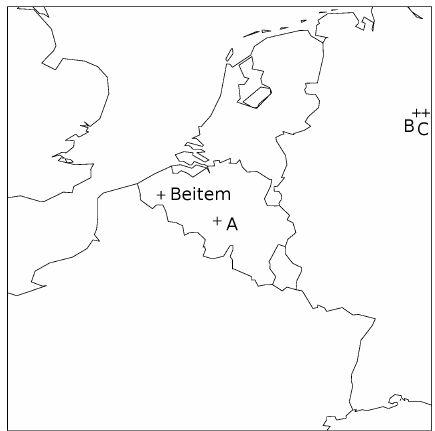
Figure 2. The operational 4km ALARO Belgium domain. The in- dicated locations will be used in the following sections. Beitem: 50.905 ◦ N, 3.123 ◦ E (Belgium). Location A: 50.534 ◦ N, 4.497 ◦ E (Belgium). Location B: 52.092 ◦ N, 9.488 ◦ E (Germany). Location C: 52.082 ◦ N, 9.722 ◦ E